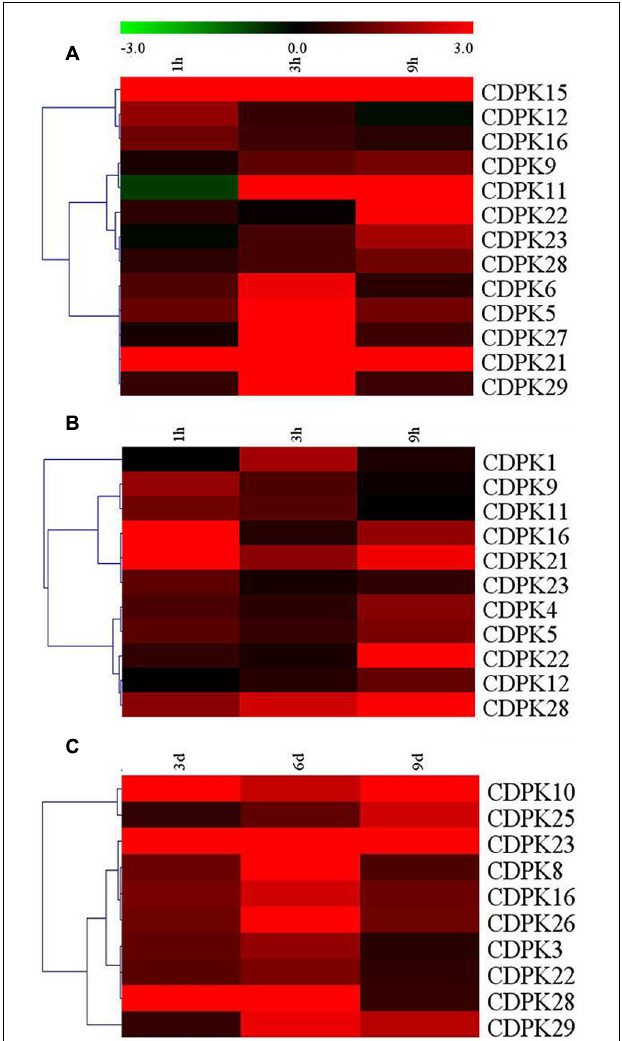
FIGURE 7 | Up-regulated expression of selected CDPK genes under different abiotic stress conditions. (A) Upregulated CDPK genes under 45 ◦ C; (B) Upregulated CDPK genes under 4 ◦ C; (C) Upregulated CDPK genes under drought. The color scale stands for the relative signal intensity values. Hierarchical clustering was deepened on the data